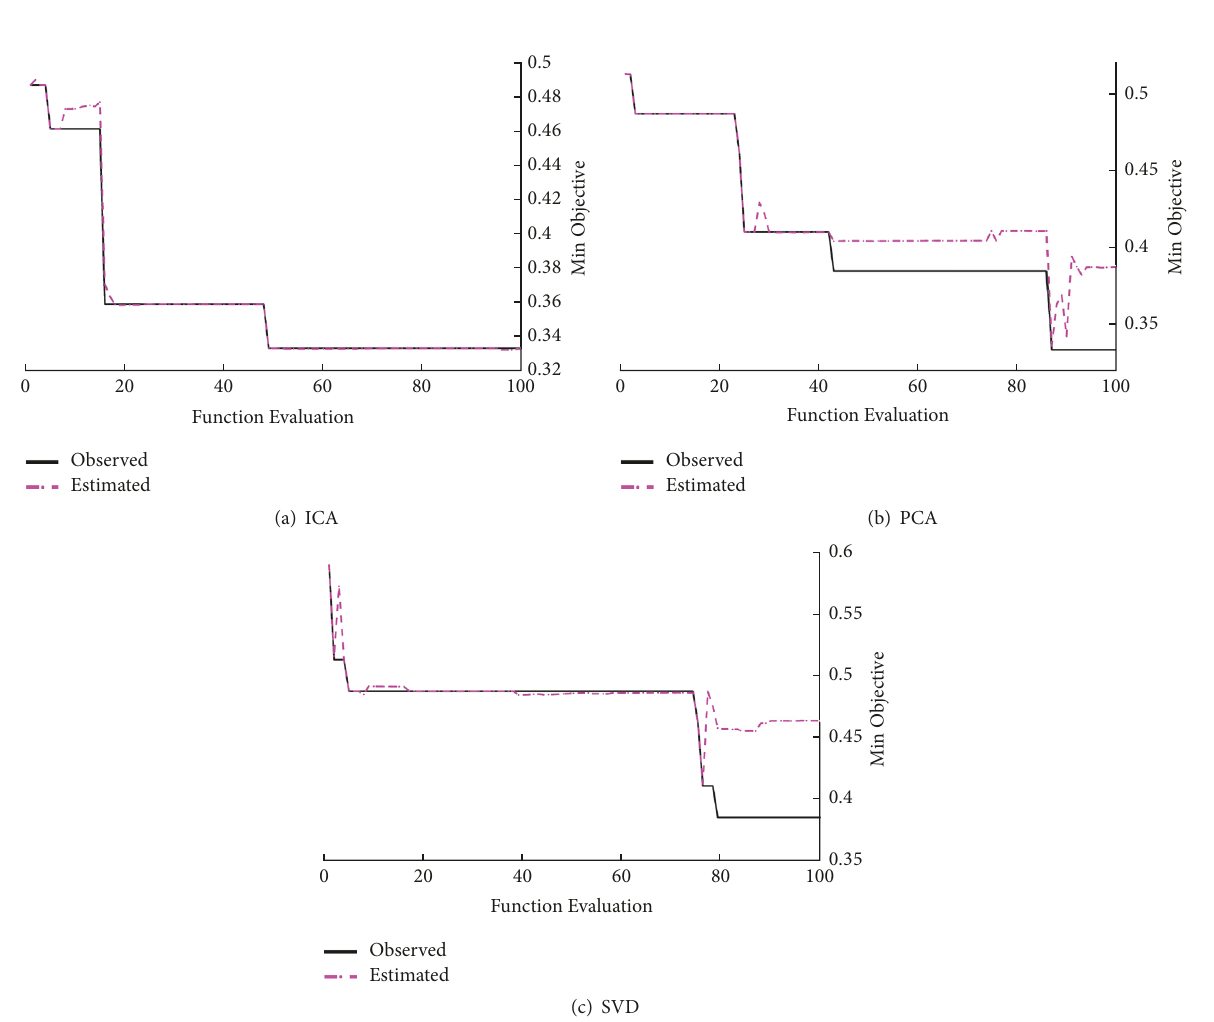
Figure 10: Convergence rates of the optimized Naive-Bayes classifier for ICA, PCA, and SVD data reduction techniques.